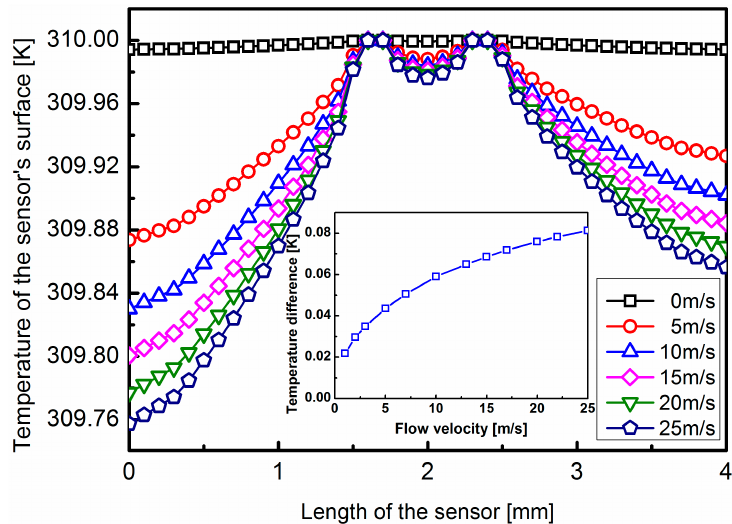
Figure 4. Simulation results of the temperature distribution on the surface of the chip. The wind speed changes from 0 to 25 m/s in a step of 5 m/s. The ambient temperature is 300 K, and the temperature of the heaters is 310 K. The upstream sensing point is at the position of 0.5 mm of the lateral axis, whereas the downstream sensing point is at the position of 3.5 mm of the lateral axis.